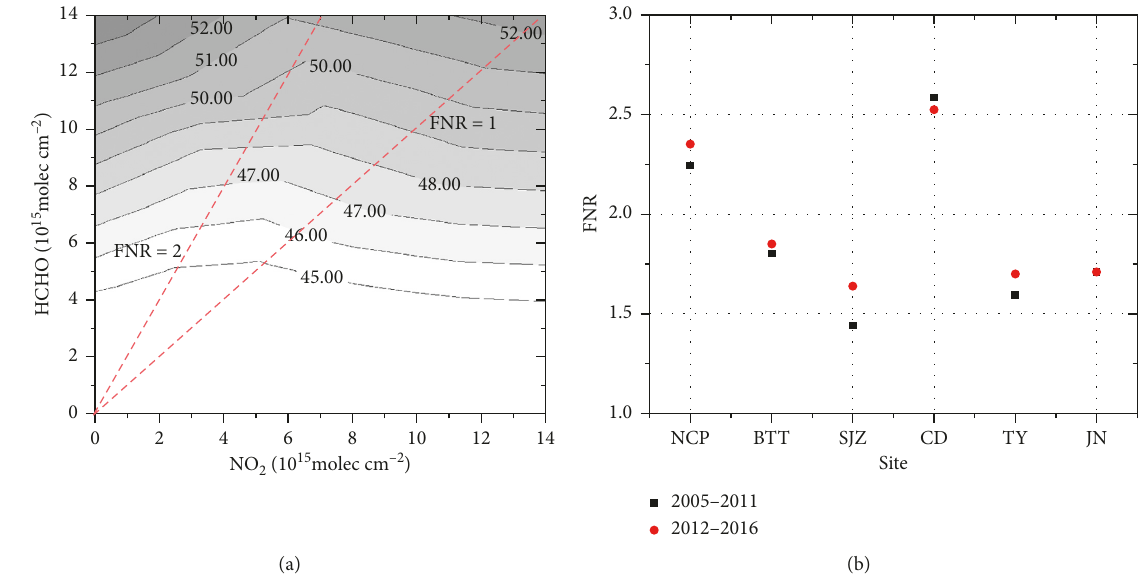
Figure 7: (a) Regional ozone-NO x -VOC sensitivity characteristics in summer in the NCP. The contours are the tropospheric O 3 column concentrations (units: DU). (b) Comparison of FNR in major cities for two phases (2005–2011 and 2012–2016) from remote sensing. FNR is defined as the ratio of tropospheric HCHO column concentration to tropospheric NO 2 column concentration.